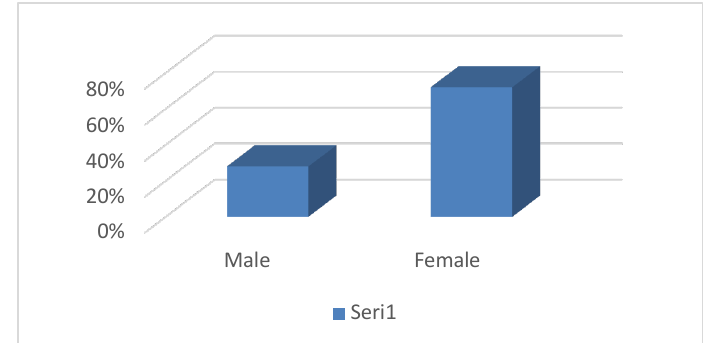
Figure 1: Gender of the consumer Out of 100 consumers 28 % male and rest 72 % were